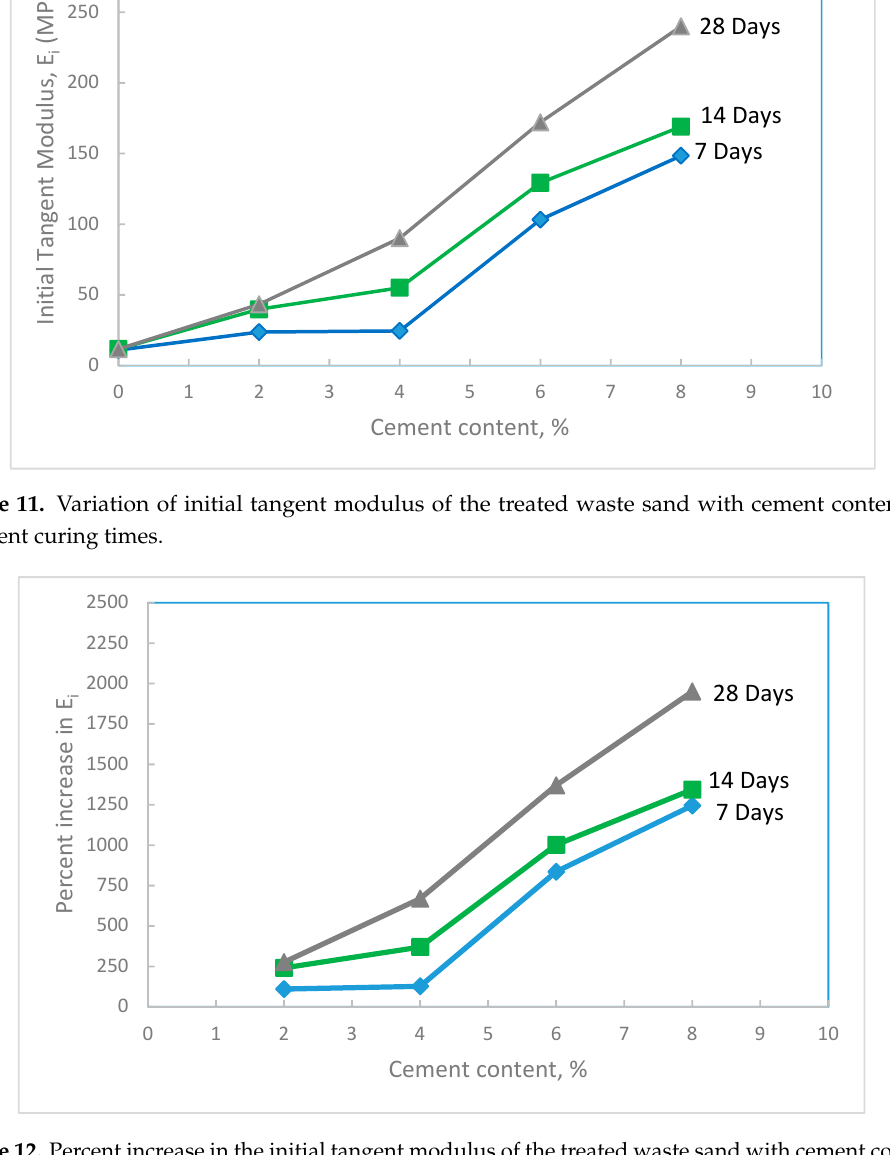
Figure 12. Percent increase in the initial tangent modulus of the treated waste sand with cement content for different curing times.